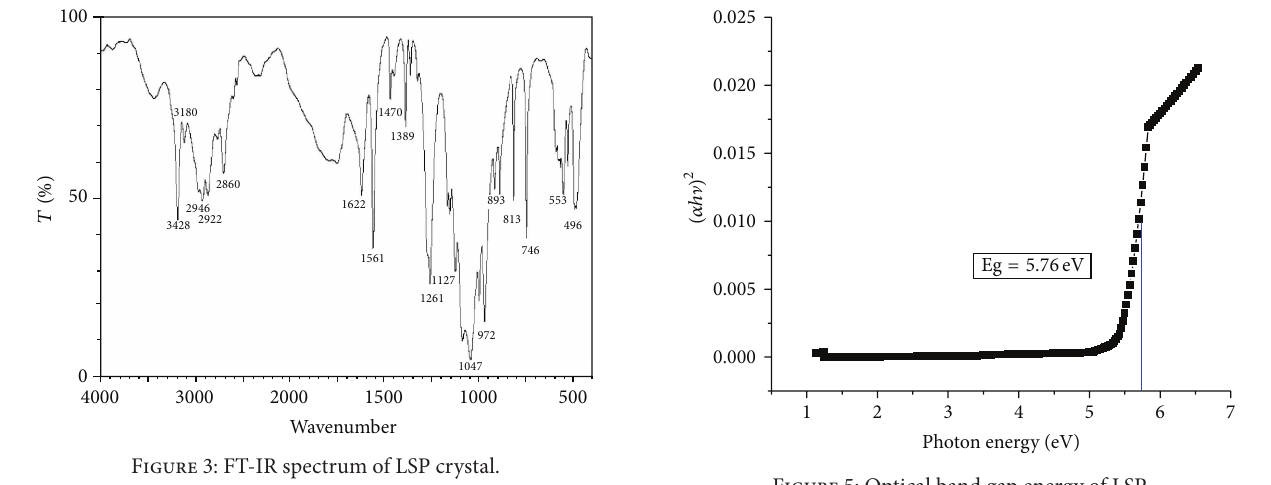
Figure 5: Optical band gap energy of LSP.